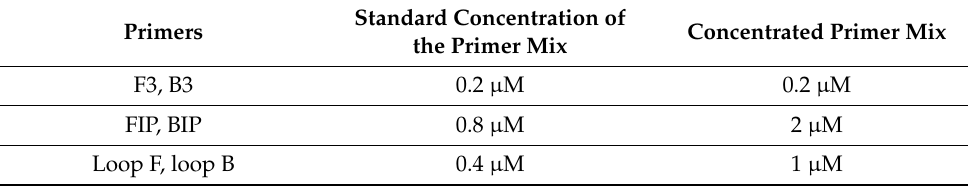
Table 3. Different concentrations of the primer mix